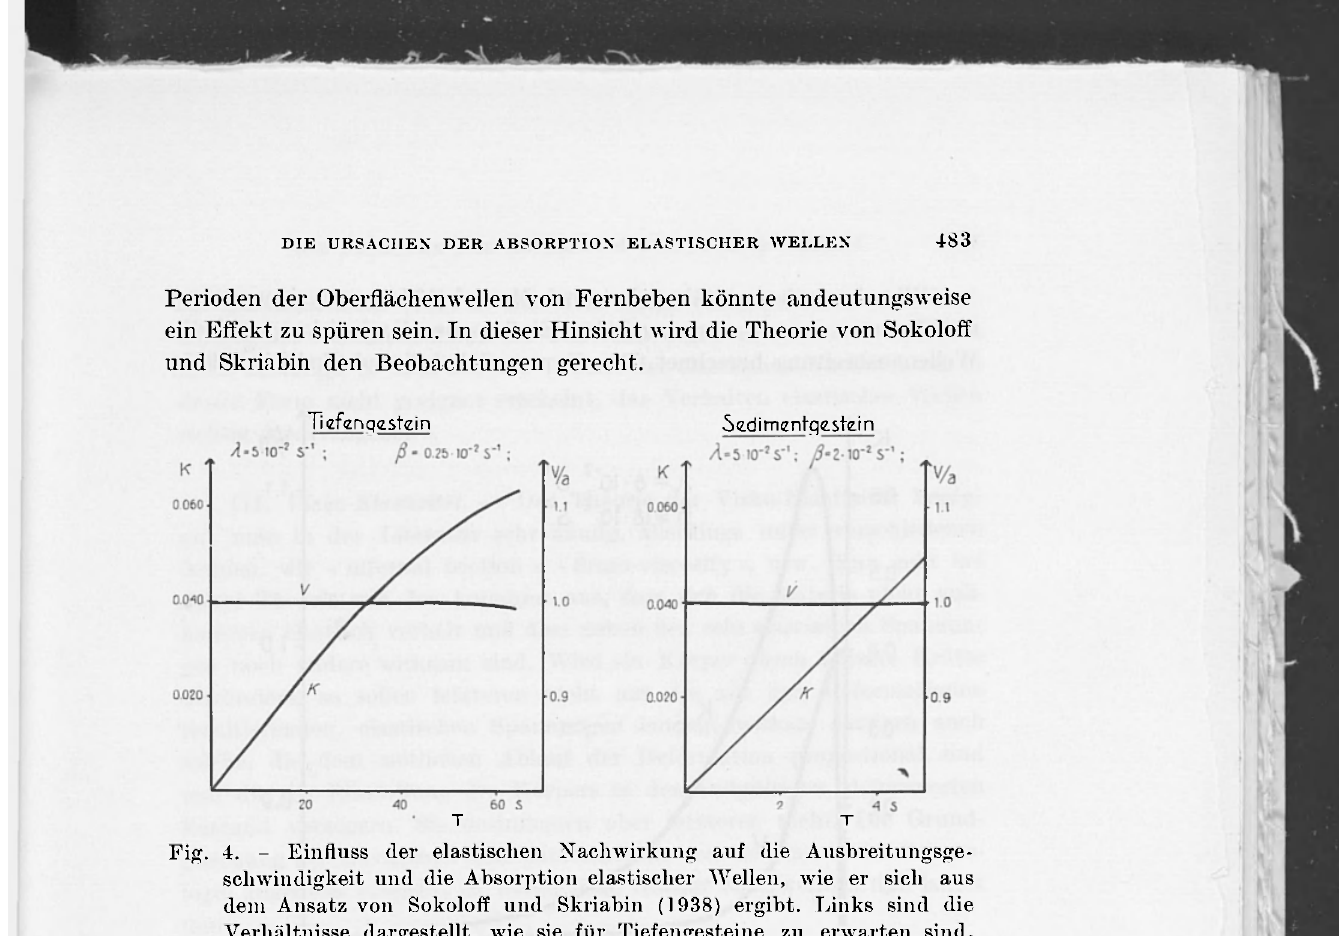
Fig. 4. - Einfluss der elastischen Nachwirkung auf die Ausbreitungsge- scliwindigkeit und die Absorption elastischer Wellen, wie er sich aus dem Ansatz von Sokoloff und Skriabin (1938) ergibt. Links sind die Verliàltnisse dargestellt, wie sie fiir Tiefengesteine zu erwarten sind. Rechts sind die Verliàltnisse dargestellt, wie sie fiir sedimentgesteine zu erwarten